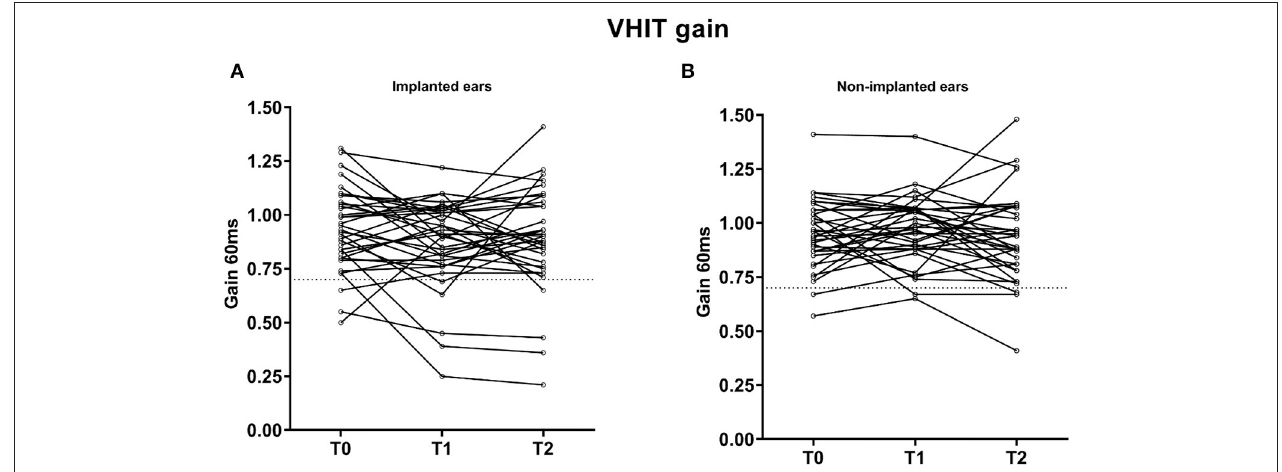
FIGURE 2 | Individual changes in vHIT gains ( n = 35) on (A) implanted and (B) non-implanted ears, respectively. Patients 3, 8, and 16 stand out with the lowest vHIT gain values. ms, milliseconds; T0, baseline before implantation; T1, first postoperative follow-up; T2, second postoperative follow-up; vHIT, video head impulse test. Observations below the dotted line are considered abnormal (vHIT = 0.7).